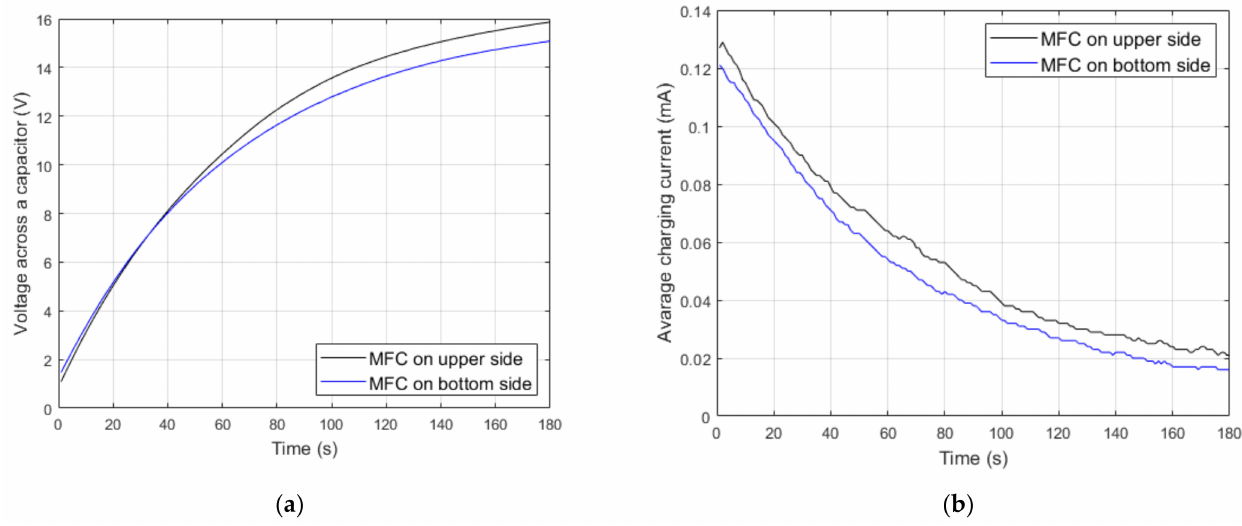
Figure 7. Charging of capacitor: ( a ) voltage across a capacitor; ( b ) average charging current.